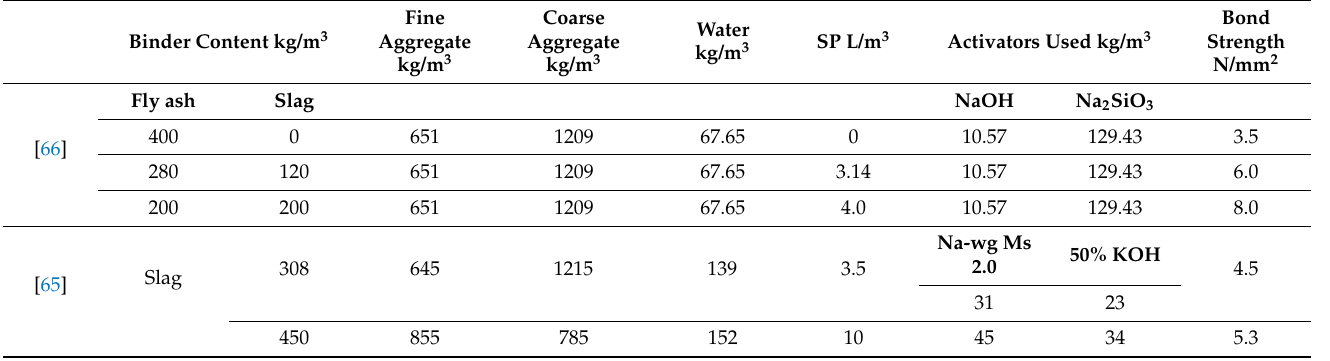
Table 4. Comparison of bond strength results of AAC.